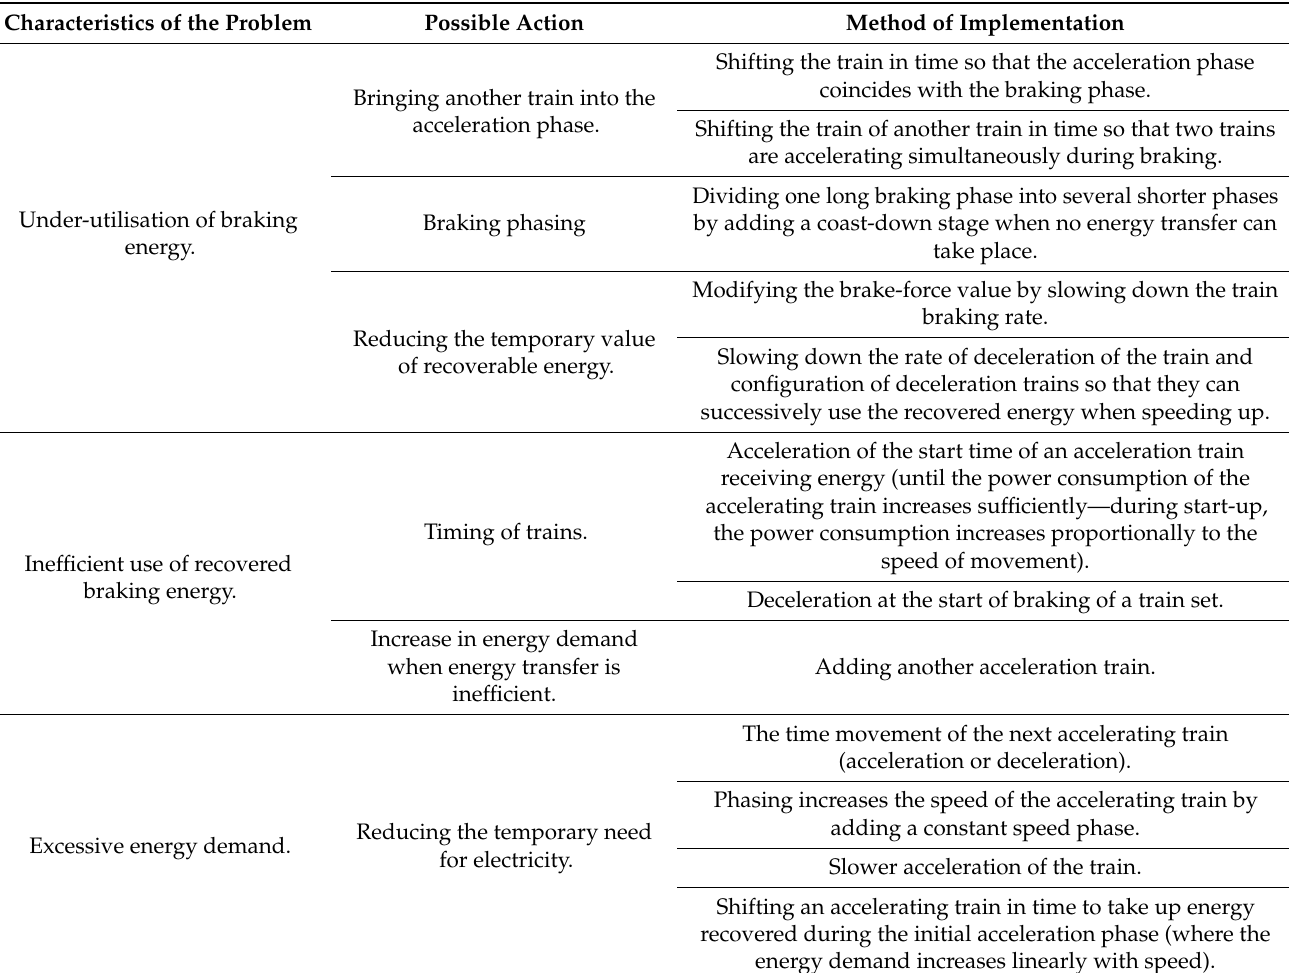
Table 2. List of possible measures within the framework of a reconfiguration of the timetable, taking into account increased energy efficiency of the